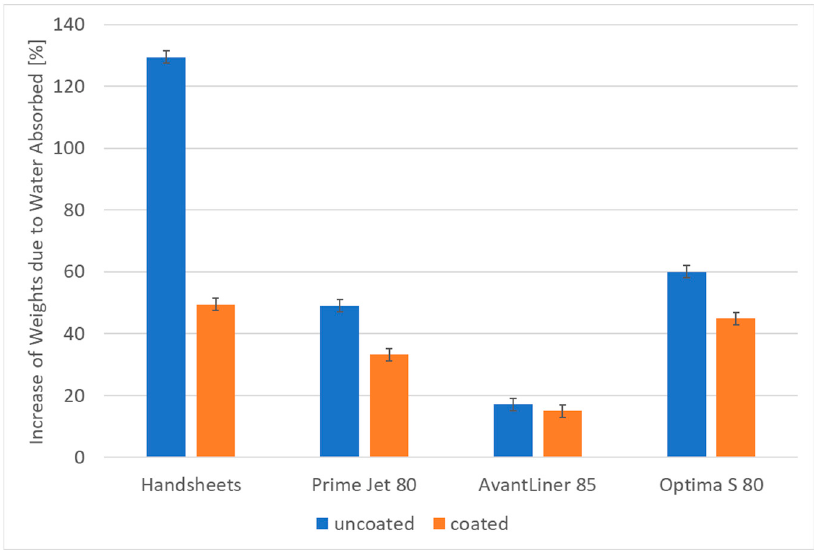
Figure 2. Average increase in weights due to water absorbed (%) (Cobb 120 s) measurements for tested samples.